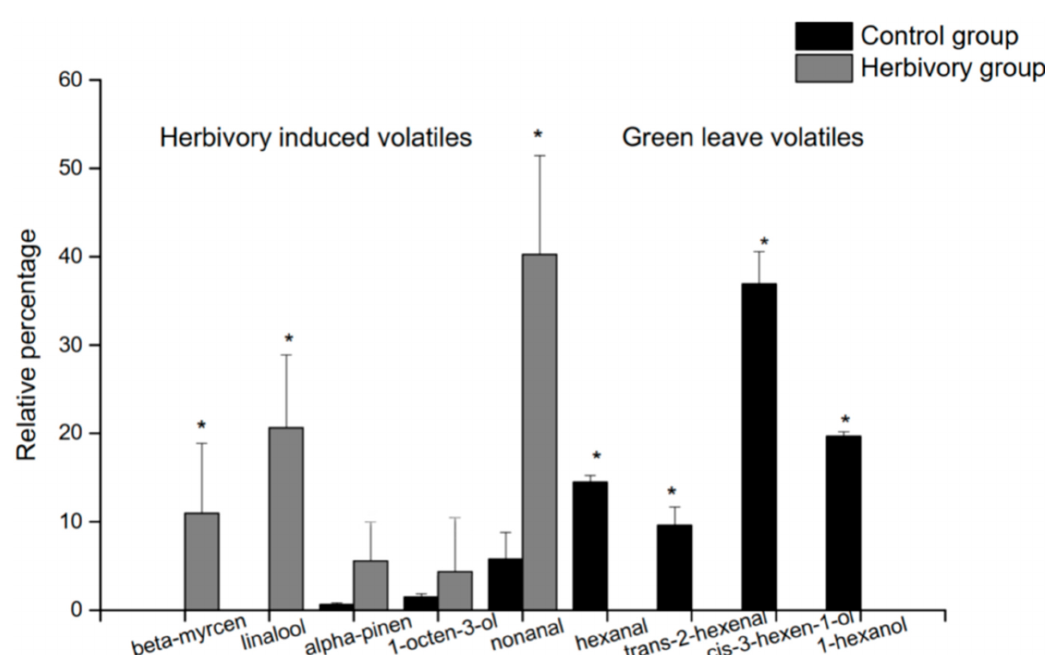
Figure 1. Relative Percentages of Nine VOCs from Damaged and Undamaged Hypolepis punctata . The Y-axis is the average relative percentage of the same compound collected from Hypolepis punctata individuals of the damaged group and undamaged group; each group is represented with a unique color. The X-axis indicates nine chemical compounds; the five on the left side of the vertical line are assumed herbivory induced compounds, and the four on the right side are green leaf volatiles. * indicates that there is a significant difference between the relative percentage of the same compound collected from the control group (HI group) and herbivory group (DI group) ( p < 0.05).